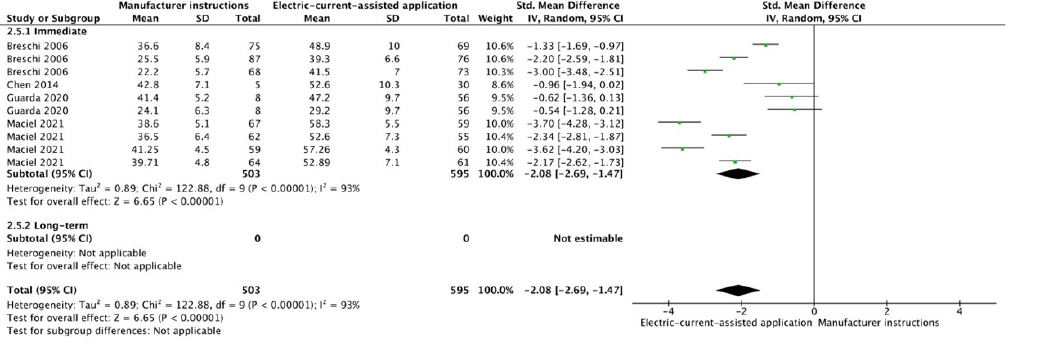
Figure 11. Forest plot showing the bond strength values when the adhesive was applied using an electric current